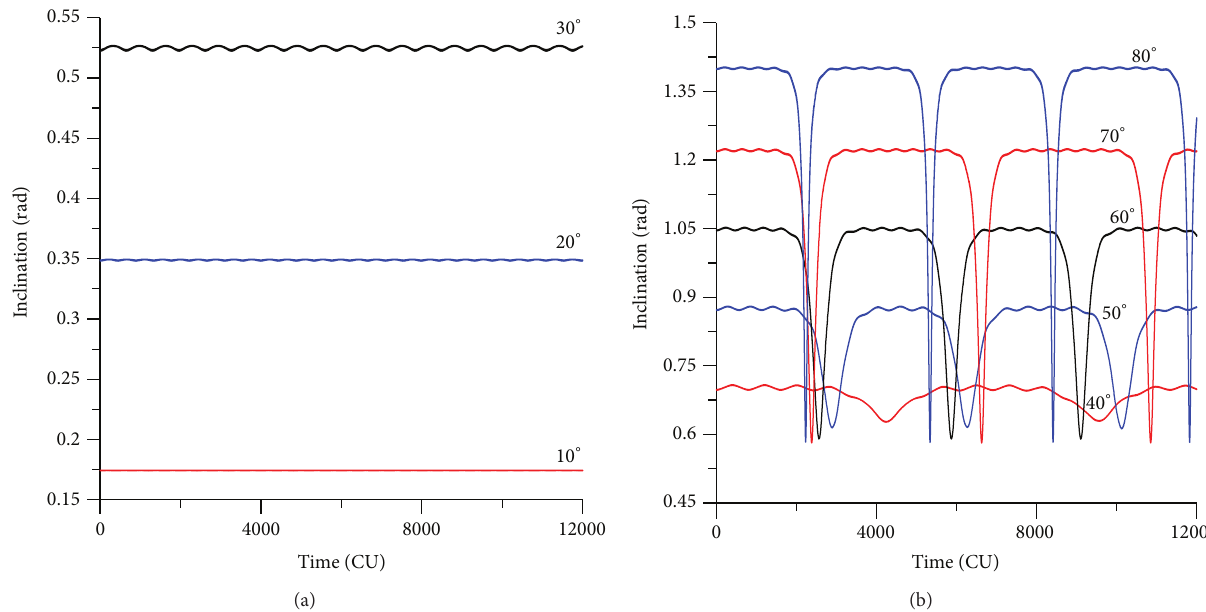
Figure 6: Evolution of the inclination for circular and direct orbits (exact model). The initial conditions are a = 0.341 canonical units, e (0) = 0, M 0 (0) = 0, 𝜔 (0) = 0, and Ω (0) = 0.